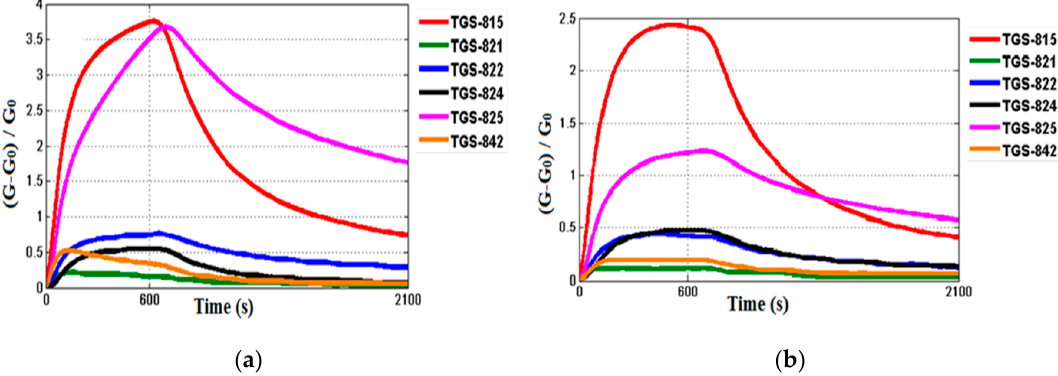
Figure 5. Sensor electrical conductance changes in the presence of ( a ) okoume, ( b ) aiele essential oils using an electronic nose system.